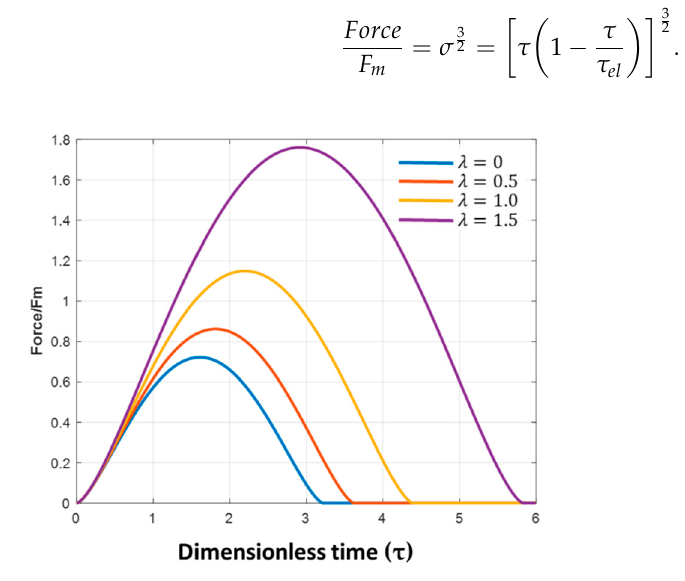
Figure 5. Force–time change quadratic function curve.